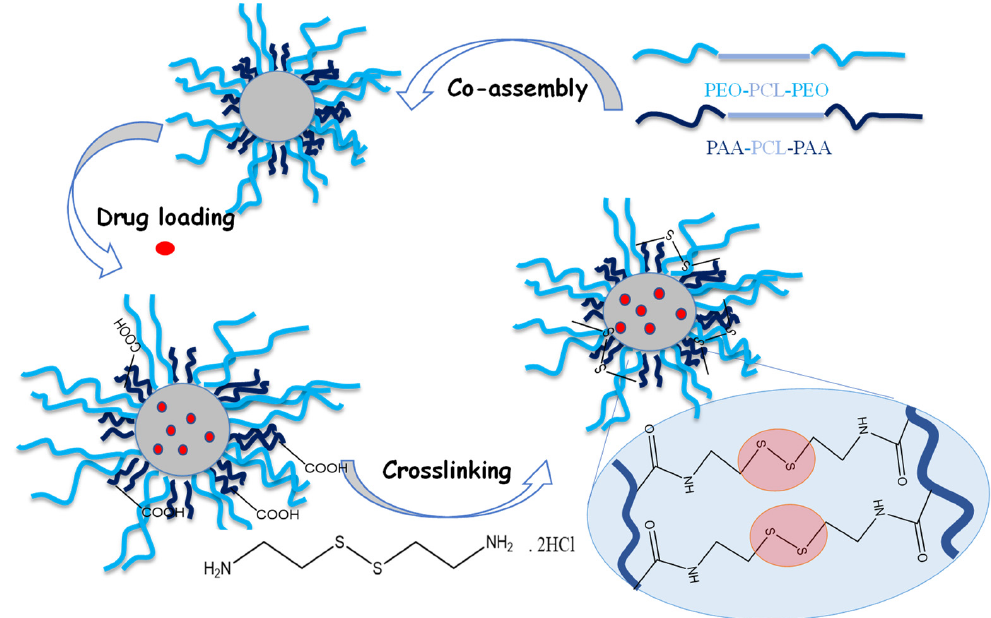
Figure 1. Schematic illustration of the preparation of redox-responsive crosslinked micellar nanocarriers based on PEO 113 -b-PCL 35 -b-PEO 113 and PAA 13 -b-PCL 35 -b-PAA 13 amphiphilic triblock